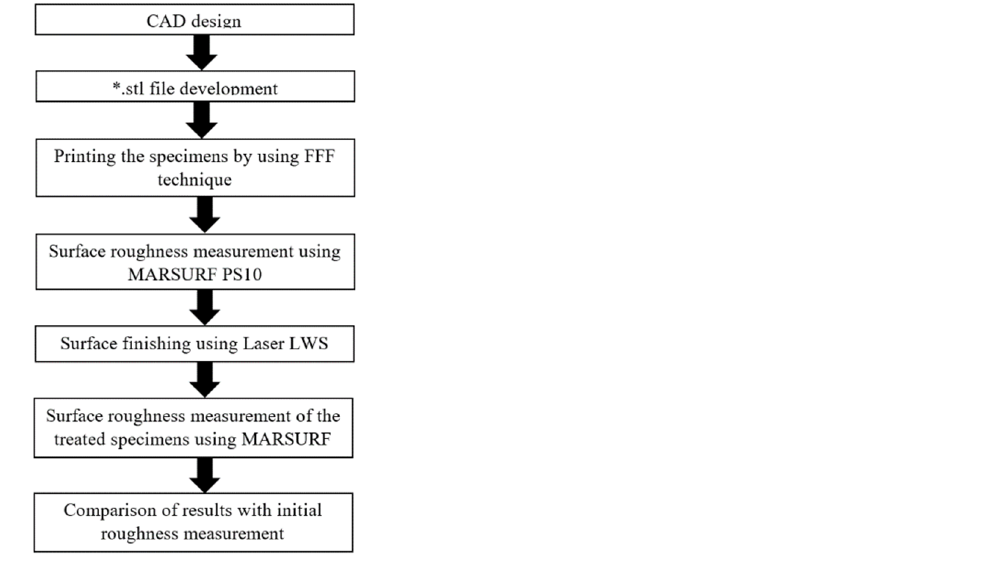
Figure 2. Experimental methodology from design to manufacturing and post ‐ processing.